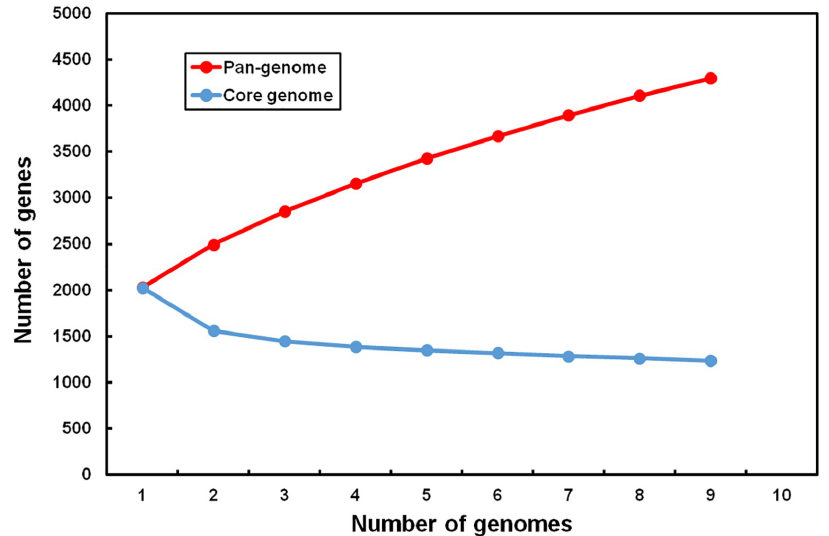
Fig 3. Size prediction for the L . ruminis pan- and core genomes. New gene numbersin the pan- and core genomesare plotted againstthe numberof added L . ruminis genomes.Each fitted curve was generated using the medianvalues for the number of new